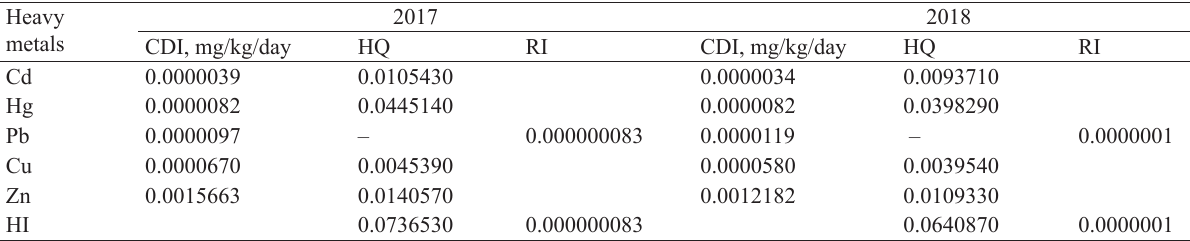
Table 6 Carcinogenic concentration of consumed fish (CDI), hazard quotient (HQ), risk index (RI), and hazard risk (HI) of elements in Mullus barbatus L. caught near the southern coast of the Black Sea in 2017 and